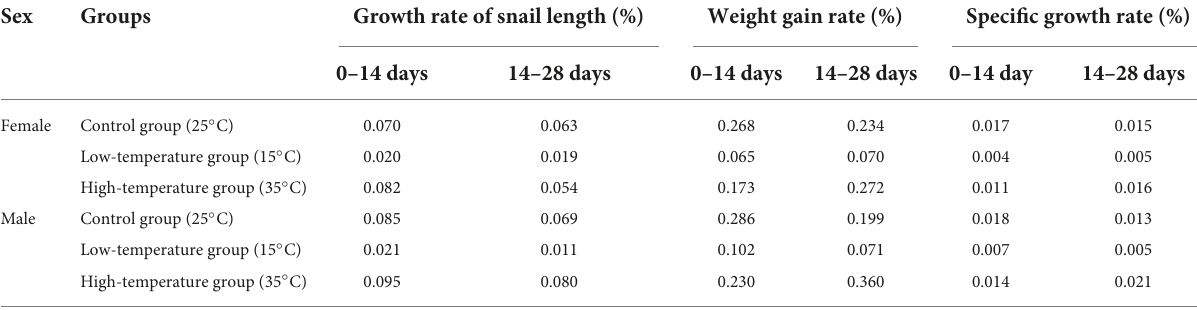
TABLE 1 Growth rate of snail length, weight gain rate, and specific growth rate of female and male Pomacea canaliculata at different temperature and treated time.